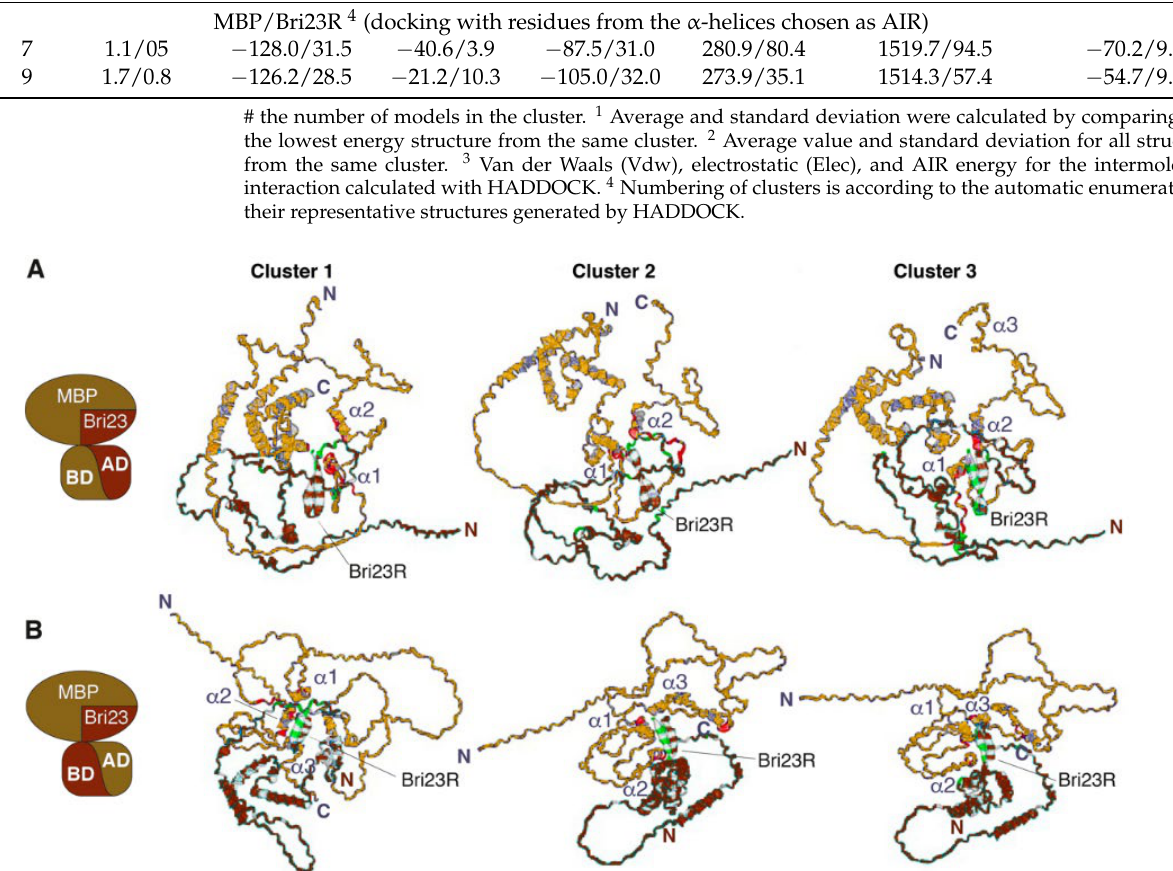
Gal4BD-MBP/Gal4AD-Bri23R and Gal4AD-MBP/Gal4BD-Bri23R complexes are shown in Supplementary Tables S2 and S3, respectively. The binding interfaces and residues par- ticipating in either polar or hydrophobic contacts are marked in Figure 3 and color- mapped in the sequences of the interacting proteins in Supplementary Figures S4 and S5, respectively. In accordance with enhanced intermolecular energies, a higher number of interfacial residues involved in the intermolecular polar contacts were detected in the best models of the Gal4BD-MBP/Gal4AD-Bri23R complex compared to those of the Gal4AD- MBP/Gal4BD-Bri23R complex (Supplementary Tables S2 and S3). These residues formed from six to twelve polar contacts between the Gal4BD-MBP and Gal4AD-Bri23R mole- cules, the majority of which were between MBP and Bri23R components of the fusion pro- teins (Supplementary Table S2). Two to four polar contacts were found in the representa- tive structures of the Gal4AD-MBP/Gal4BD-Bri23R complex (Supplementary Table S3). At the same time, the Van der Waals energy of the intermolecular interactions was similar for both Gal4BD-MBP/Gal4AD-Bri23R and Gal4AD-MBP/Gal4BD-Bri23R complexes (Ta- ble 2). The location of the interacting residues in the binding interfaces varied between dif- ferent clusters of each complex, though the residues fro m Bri23R and at least two α -helices (α1 and α2) of MBP, as well as their nearest surroundings, were always involved (Figure 3, Supplementary Figures S4 and S5). In addition to the intermolecular contacts between MBP and Bri23R, other components of the fusion proteins including Gal4AD, Gal4BD and connecting linkers were involved in the complex formation, which was in accordance with